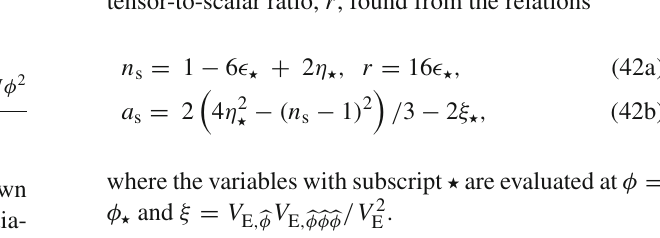
Table 1 Mass spectrum along the path in Eq. (21) for EMI – we take n = 1 for δ EM and EM2 whereas n = 2 for EM4 Fields Eingestates Mass